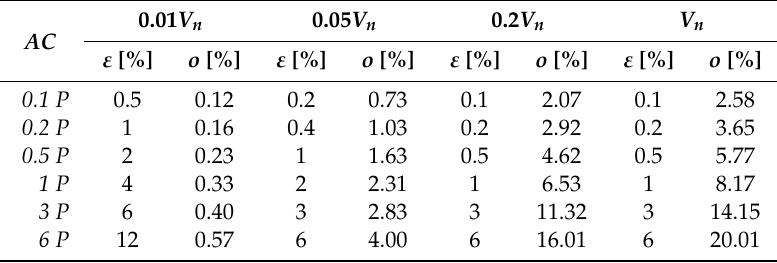
Table 6. Results for protective purpose LPVTs.